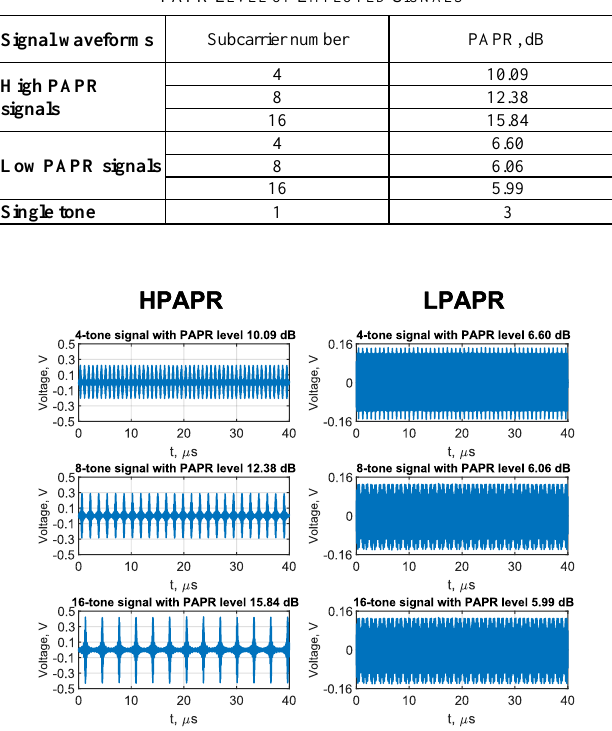
Fig. 1. Waveforms of the employed multicarrier signals with average power of −10